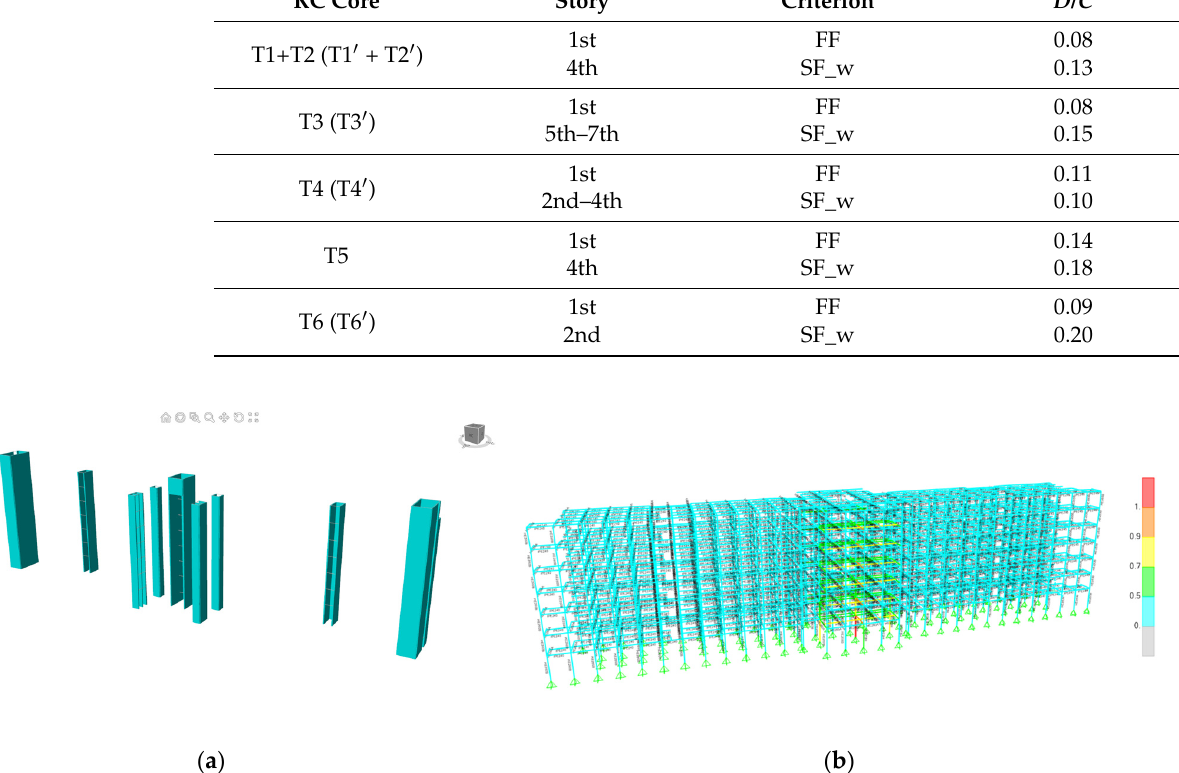
Table 9. Maximum demand-to-capacity ratios for steel members under gravitational loads.